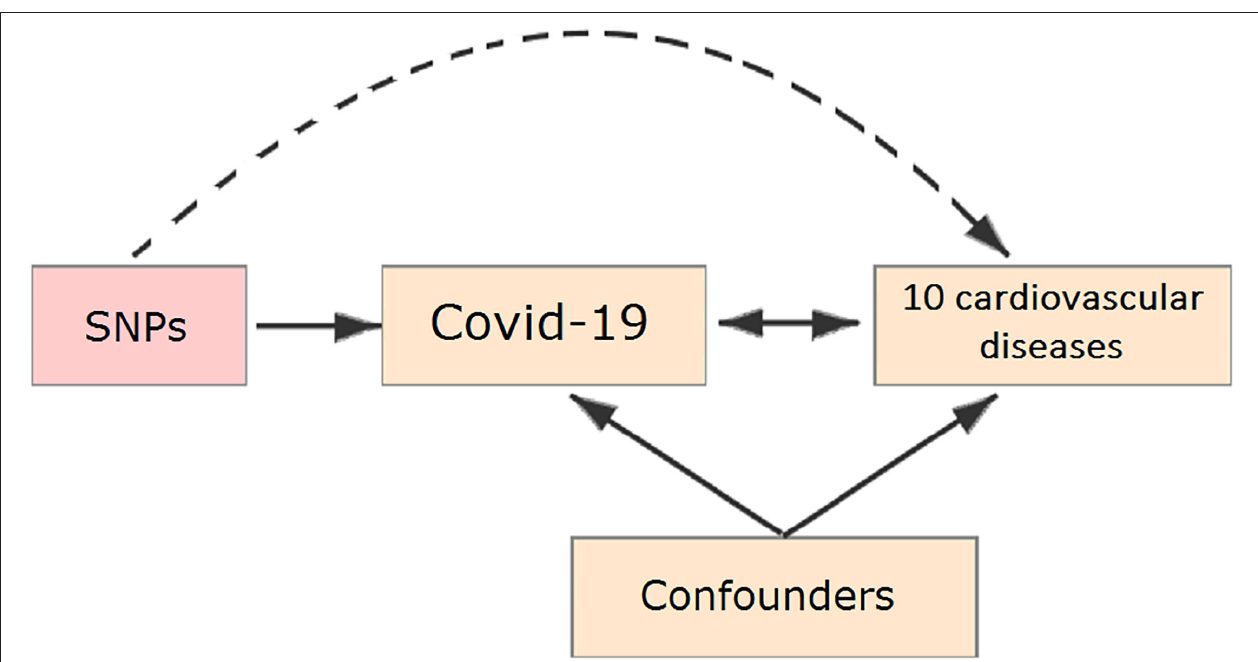
FIGURE 1 | Schematic representation of a Mendelian randomization (MR) analysis. We selected single-nucleotide polymorphisms (SNPs) associated with coronavirus disease 2019 (COVID-19) and the corresponding effect for these SNPs was estimated based on the risk of 10 cardiovascular